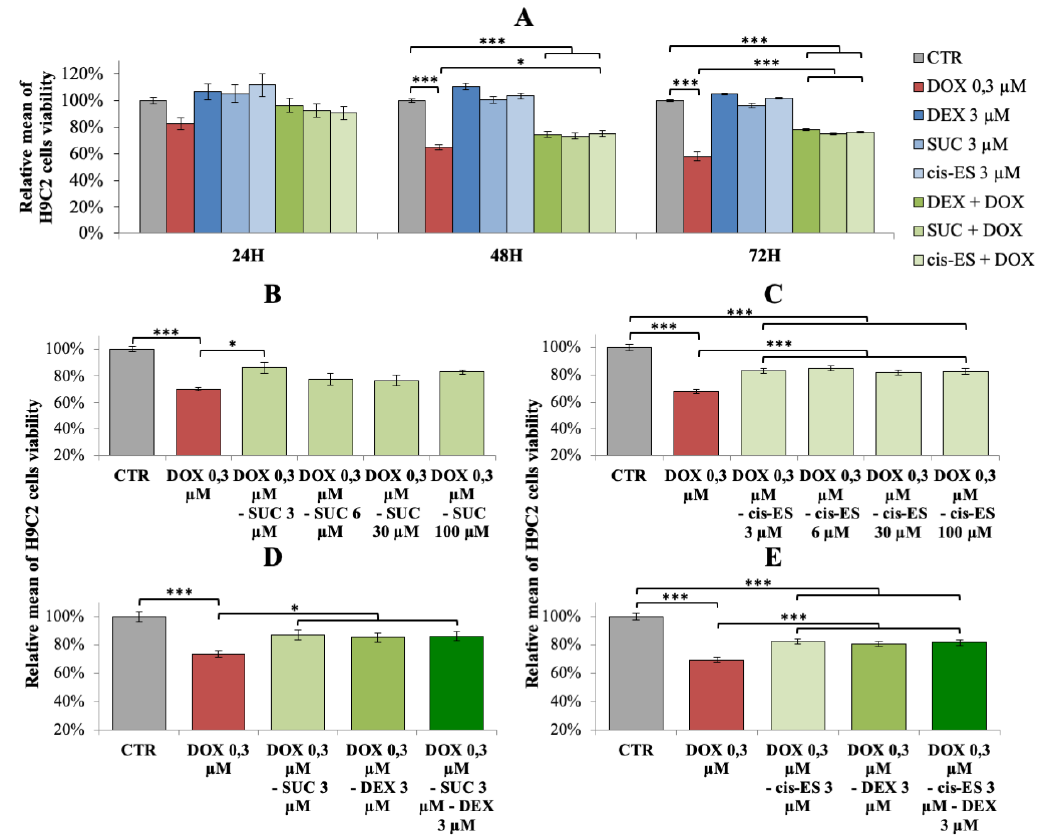
Figure 2. Relative mean ( +/ − SEM) of the H9C2 cell viability. ( A ) Exposure (24, 48 and 72 h) to doxorubicin (DOX) and cardioprotective compounds administrated alone or 30 min prior to DOX exposure. ( B ) Exposure (48 h) to DOX alone and with increasing doses of succinate (SUC). ( C ) Exposure (48 h) to DOX alone and with increasing doses of cis- epoxysuccinate ( cis -ES) . ( D ) Exposure (48 h) to DOX alone and with a combination of dexrazoxane (DEX) and SUC. ( E ) Exposure (48 h) to DOX alone and with a combination of DEX and cis -ES. ANOVA one-way with multiple comparisons: * p -value < 0.05 and *** p -value < 0.001. CTR: